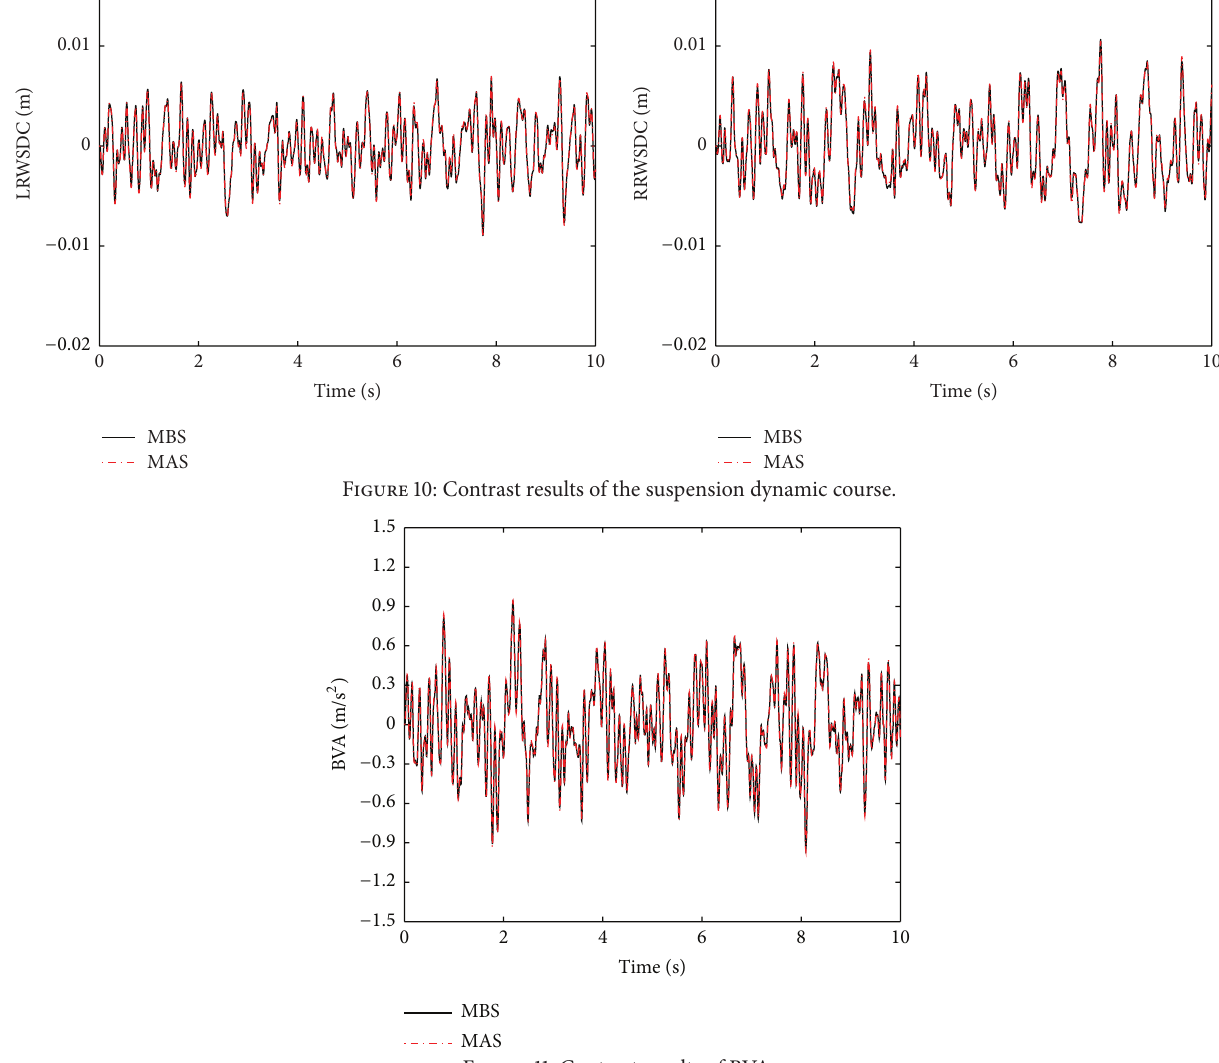
Figure 11: Contrast results of